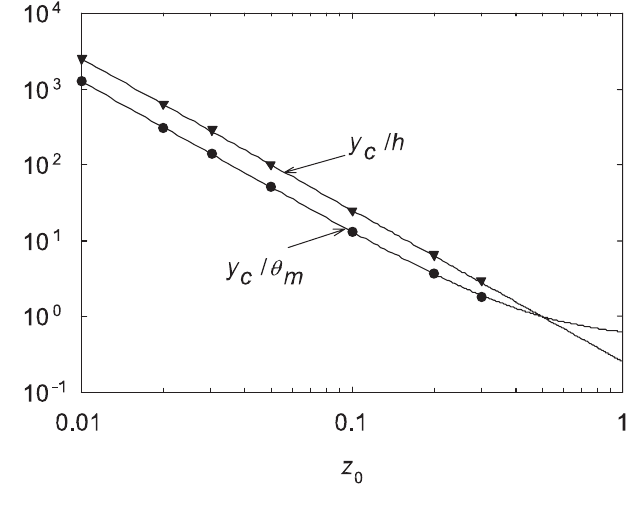
FIG. 3. Dependence on Rayleigh length z of the maximum 0 of the beam center from the original cavity axis excursion y c or undergoes transverse shift h . Tilt and when a mirror tilts by (cid:3) m shift are plotted separately. The agreement between beam theory (lines) and wave simulations (points) is excellent over many orders of magnitude. For an FEL with S (cid:2) 10 m and (cid:1) (cid:2) 1 (cid:4) m , (cid:2) 10 corresponds to 1.8 y c